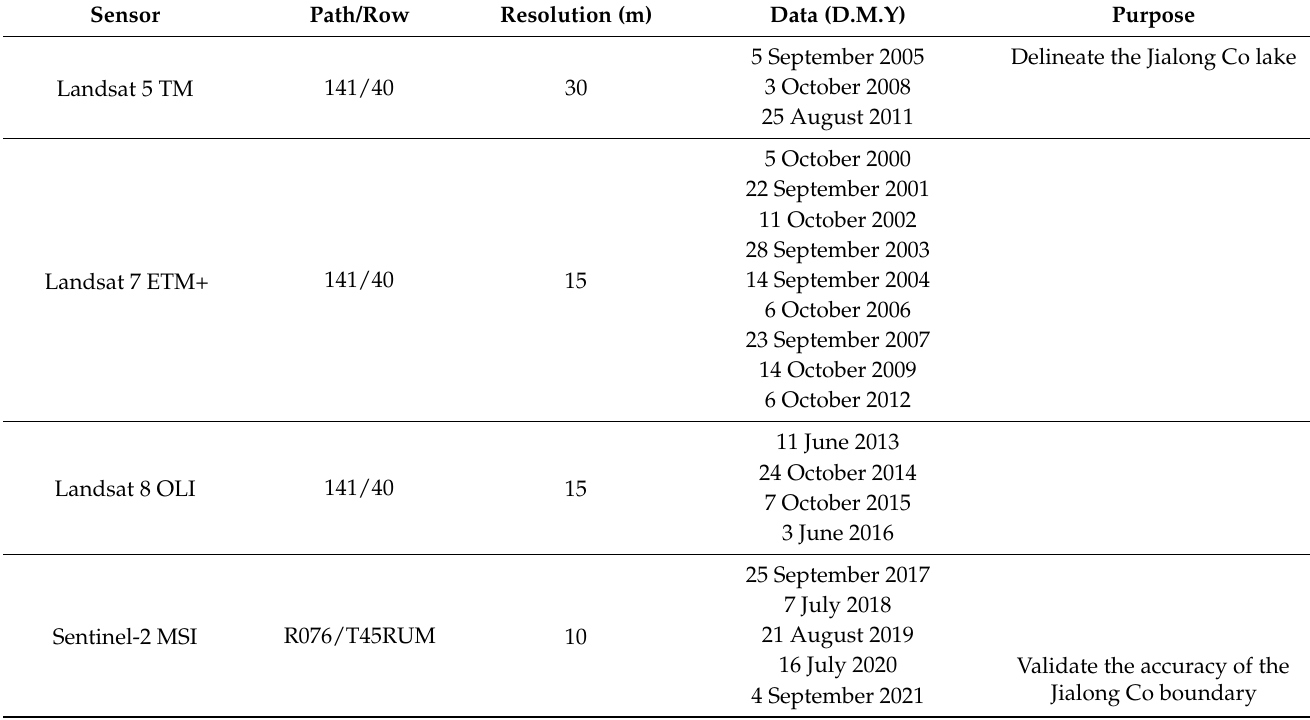
Table 1. Remote sensing data.